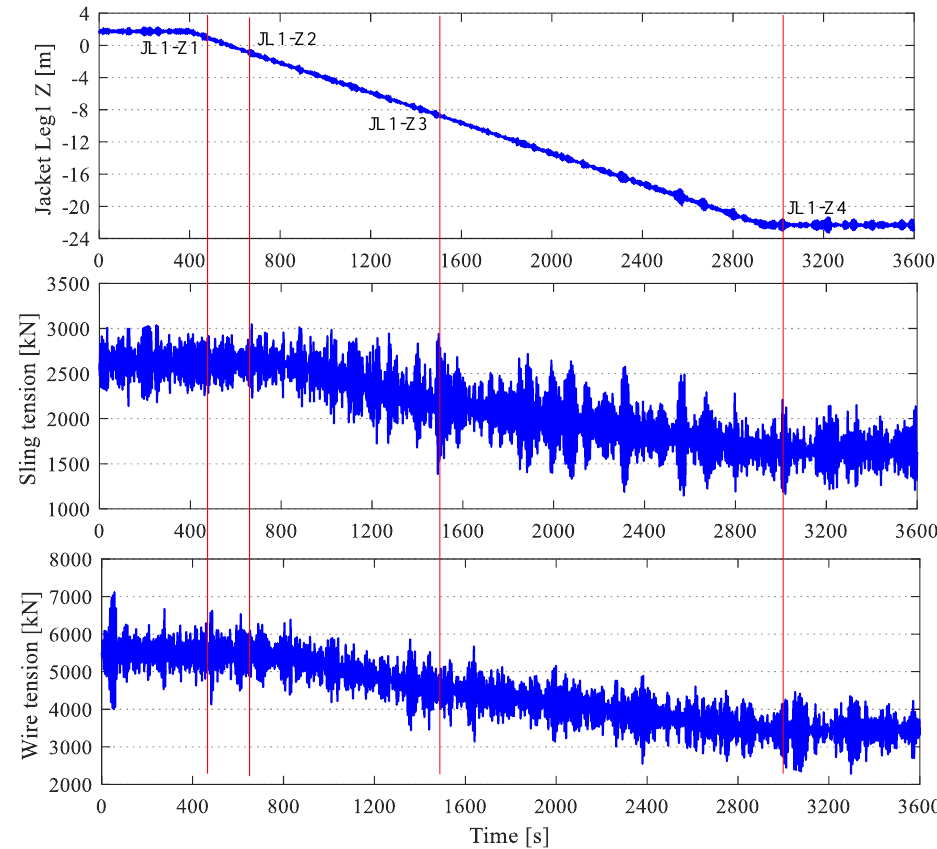
Figure 9. Response time series of the entire lowering process. ( H s = 1.5 m, T p = 7 s, Dir = 45 deg, Nonstationary). J. Mar. Sci. Eng. 2021 , 9 , x FOR PEER REVIEW